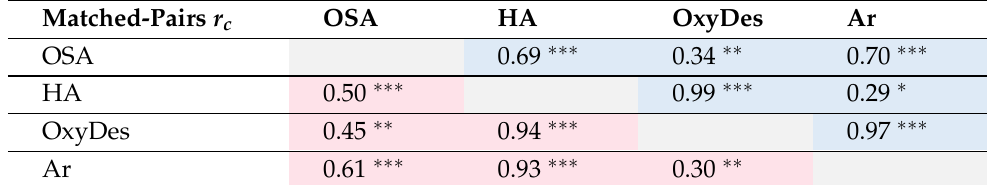
Table 4. The matched-pairs r c values of interquartile ranges of PAT distributions between different events related to sleep-disordered breathing after (blue background) and before post-processing (red background), where OSA—obstructive sleep apnea, HA—hypopnea, OxyDes—oxygen desaturation, Ar—arousal events. p < 0.001 and r c < 0.30 is marked ∗ , p < 0.001 and r c ≥ 0.30— ∗∗ , p < 0.001 and r c ≥ 0.50— ∗∗∗ .